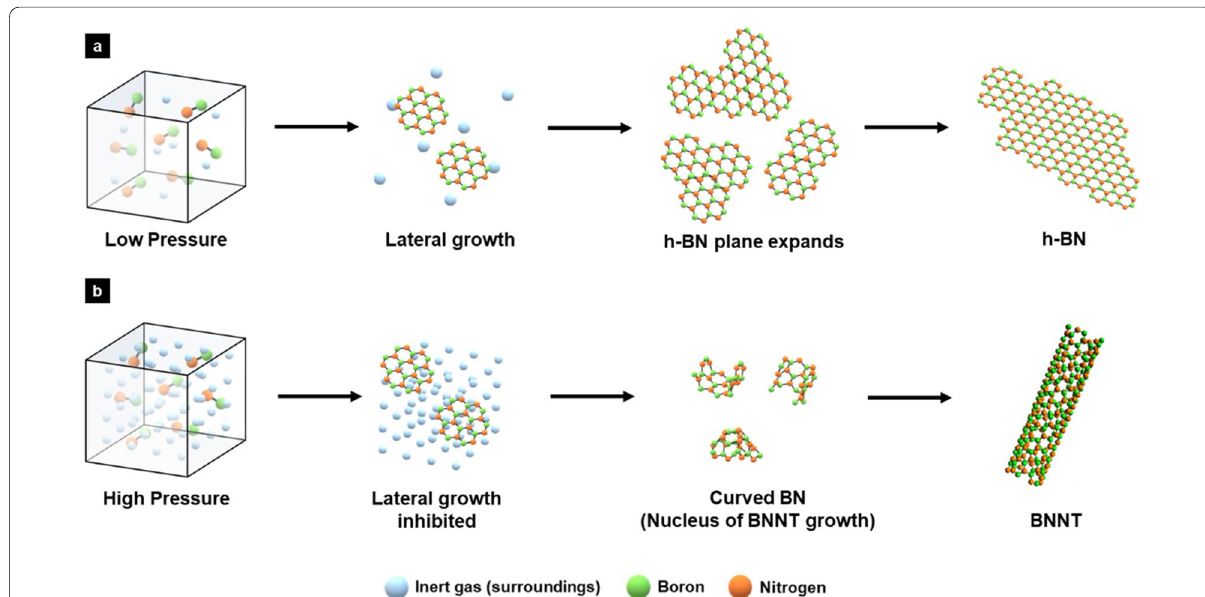
Fig. 5 Mechanism of nucleus formation of BNNT synthesis. a At low pressure, B‑N radicals bond each other quickly, and h‑BN forms in a lateral direction. b At high pressure, lateral growth of h‑BN is inhibited by surrounding gas, so curved h‑BN forms, and can nucleate BNNT